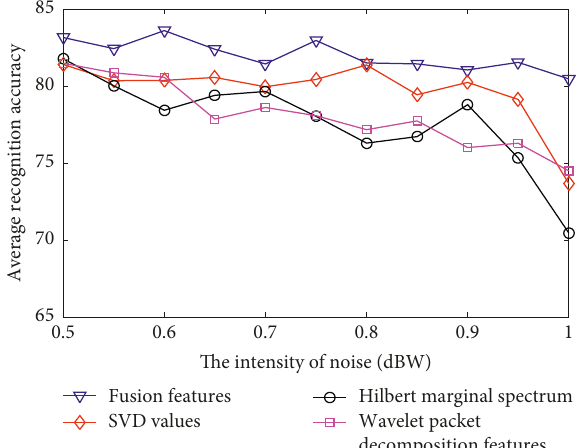
Figure 16: Recognition effect of different eigenvalues when noise signal of different intensities is added into